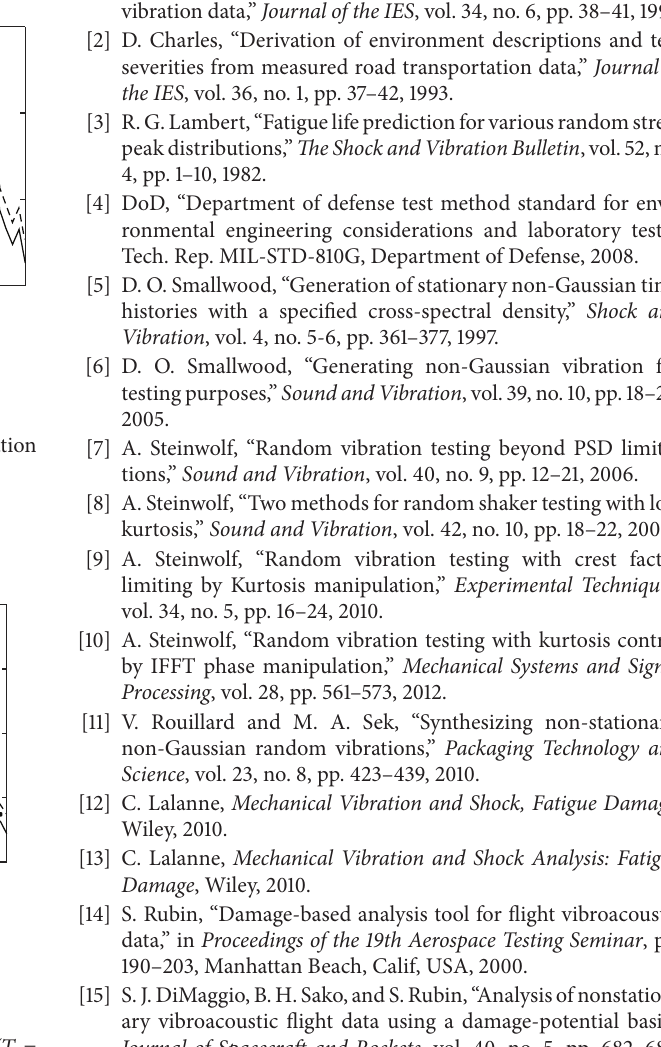
Figure 19: The FDS of the field data and the equivalent PSD ( 𝑇 = 120